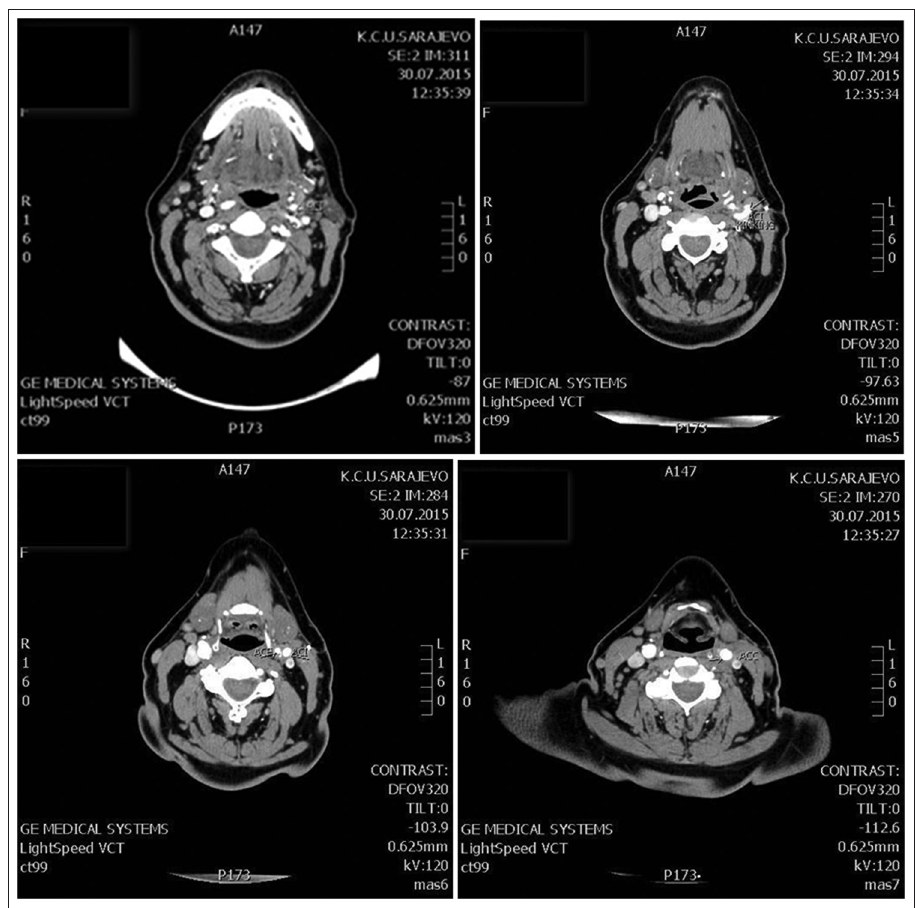
FIGURE 3. Six months after the surgical repair, no aneurysm was observed with control computed tomography angiography . The distal internal carotid artery demonstrated preserved width of the circulating lumen and appropriate contours without visible defects in the contrast